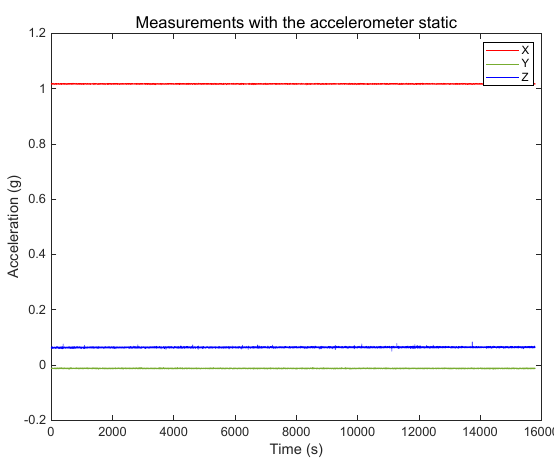
Figure 12. Measurements with the sensor static for 4.4